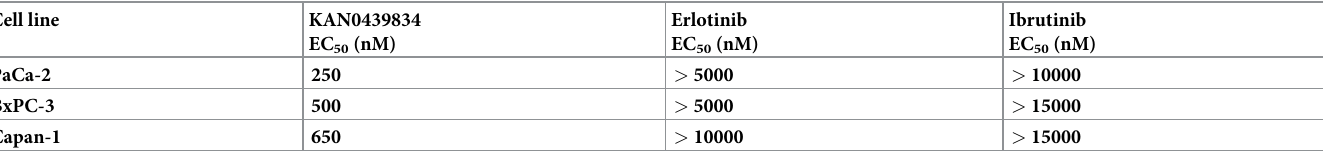
Table 1. EC50 values (nM) for KAN0439834, erlotinib and ibrutinib in three pancreatic cancer cell lines. Cell